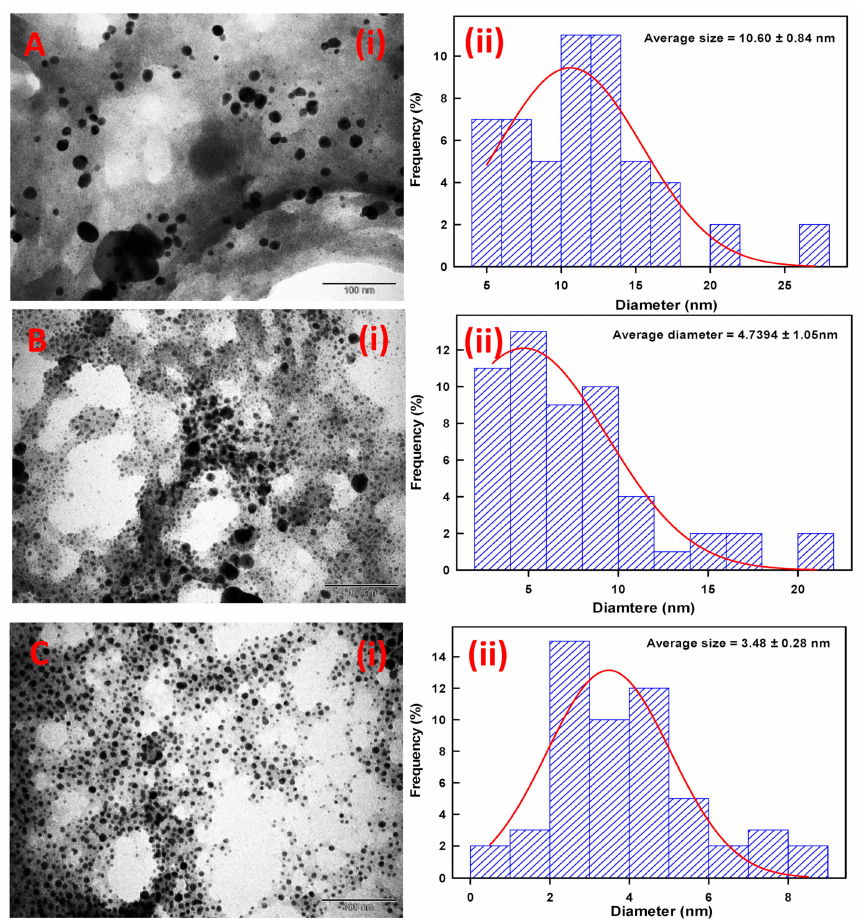
Figure 5. TEM and ImageJ-based comparative analysis of TCE-Ag-NPs. Panels ( i ) in ( A – C ) demon- strate TEM images of TCE-Ag-1, TCE-Ag-2, and TCE-Ag-3 NPs, respectively. Whereas, the histograms shown in panels ( ii ) in ( A – C ) demonstrate the average particle size and particle size distribution in the corresponding TEM images,